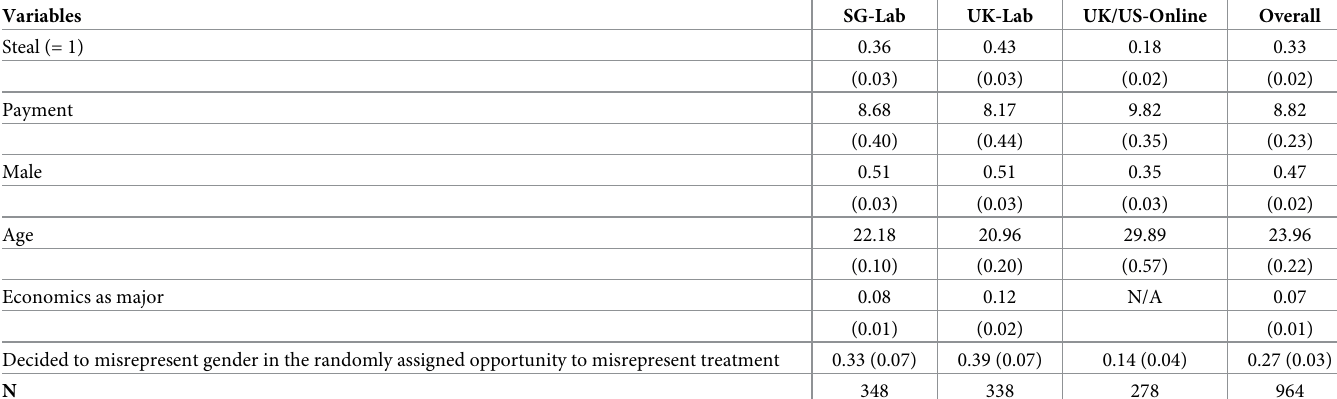
Table 1. Selected characteristics by location of the